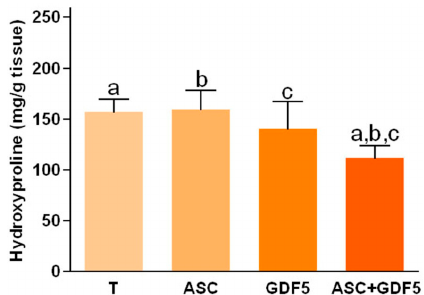
Figure 5. Tendons hydroxyproline concentration: Observe the lower value in the ASC+GDF5 group in relation to the other groups. The same letter among groups corresponds to a significant difference between them ( p ≤ 0.05).